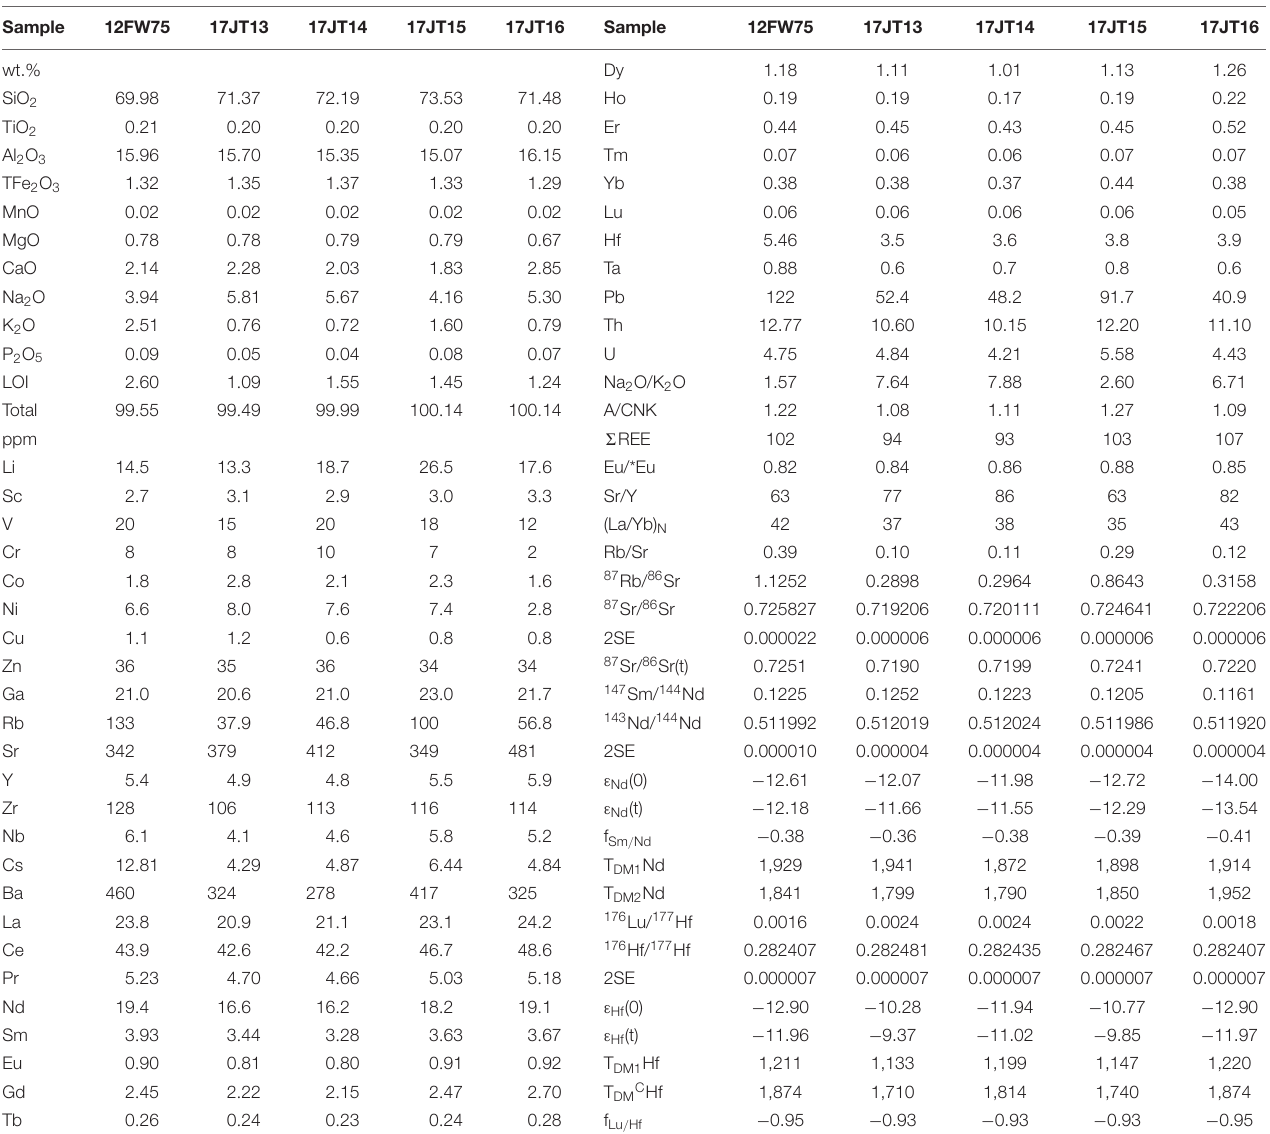
TABLE 1 | Whole-rock geochemical compositions for Haweng granodiorite porphyries.